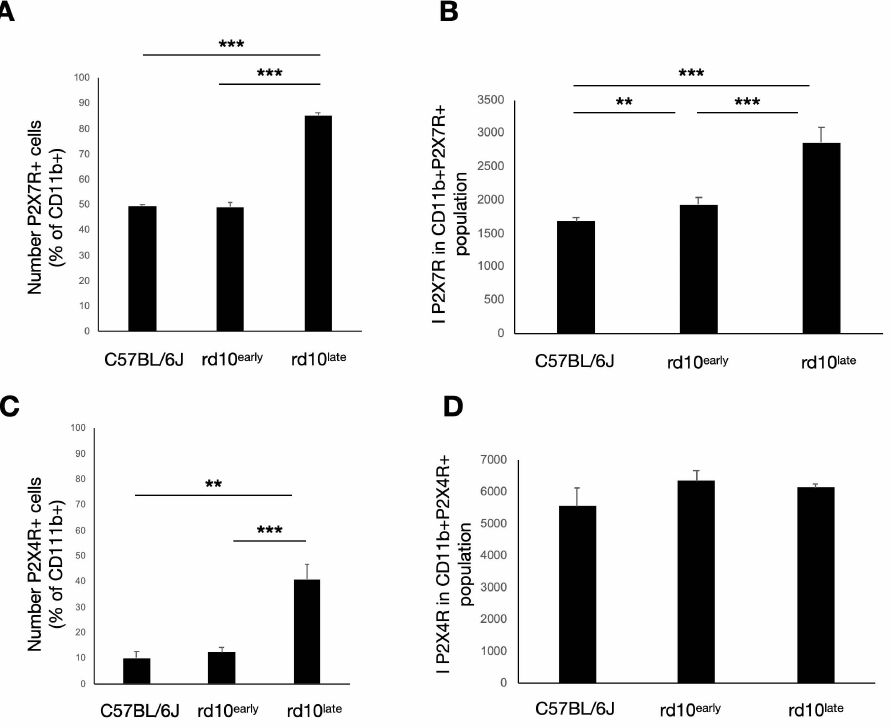
Figure 6. P2X7R and P2X4R expression in retinal myeloid cells (CD11b + ). The CD11b immunoreactive cell population was analyzed by flow cytometry. Bar graphs show the number of CD11b + cells expressing P2X7R ( A ) and the mean intensity of P2X7R fluorescence values ( B ). Also, the number of CD11b + cells expressing P2X4R is shown ( C ), and the mean intensity of P2X4R fluorescence values ( D ). C57BL/6J: postnatal day (P)47; rd10early: P18 and rd10late: P44. ** p < 0.01, *** p <